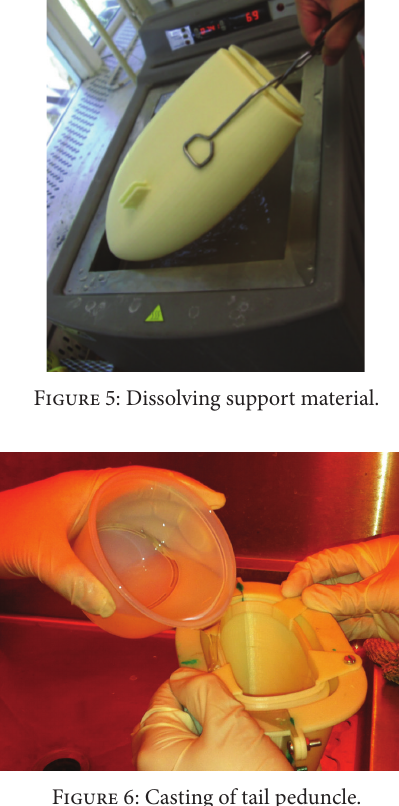
Figure 6: Casting of tail